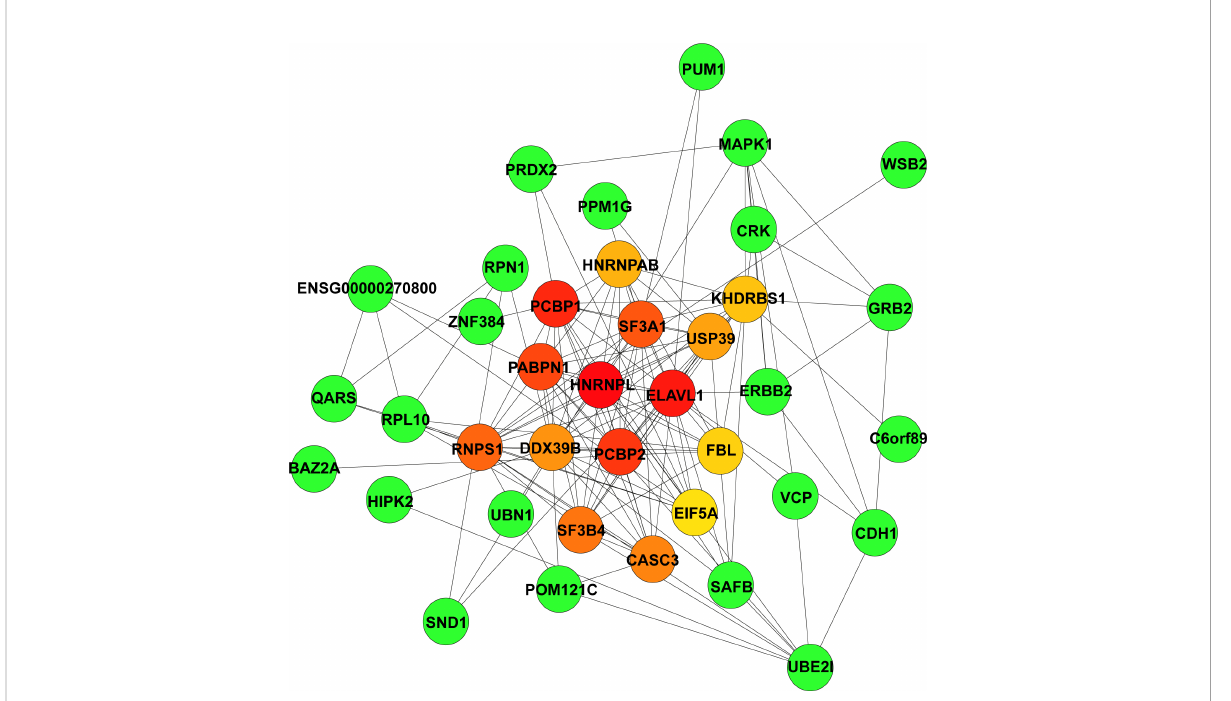
FIGURE 3 Identi fi cation of highly connected hub genes in the PPI network. PPI networks derived from Cytoscape using the cytoHubba plugin and the MCC algorithm for the 165 hub genes from the green module. Among the top 15 genes, the higher the MCC-based connectivity score is, the redder the colour of the node (gene). Neighbour genes in the module are presented in green. PPI, protein – protein interaction; MCC, maximal clique